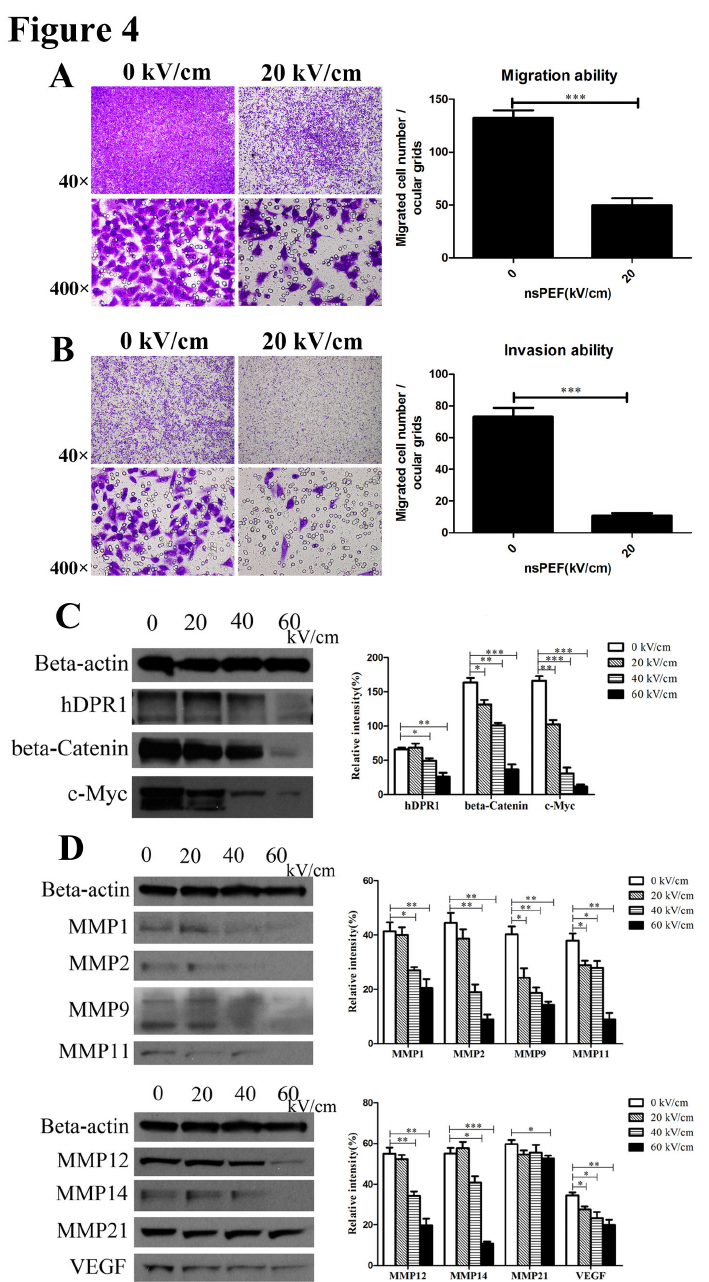
Figure 4. NsPEF inactivates cancer cells metastasis and invasion by inhibiting Wnt/β-Catenin signaling pathway to down- regulate expressions of VEGF and MMPs family proteins in vitro. (A) Migration ability of cancer cells exposed to nsPEF was tested by trans-well assay. The migrated cells exposed to nsPEF were stained purple by 0.1% crystal violet solution, observed under light microscope for 40 or 400 magnifications, and counted for statistical analysis. Original magnification, 40× & 400×. ***p<0.001. (B) Invasion ability of cancer cells exposed to nsPEF was detected using matrigel invasion assay. After nsPEF treatment, the cells that possessed invasion ability penetrated through the matrigel, were stained purple by 0.1% crystal violet solution, and were counted for statistical analysis. Original magnification, 40× & 400×. ***p<0.001. (C) Protein expressions of Wnt/β- Catenin signaling pathway including hDPR1, β-Catenin and c-Myc in cancer cells after exposure to nsPEF with different intensities were detected by Western-blot assay. (D) Protein expressions of MMPs family and VEGF in cancer cells after exposure to nsPEF with different intensities were detected by Western-blot assay. Relative intensity of each protein was analyzed by Photoshop CS4 software. *p<0.05, **p<0.01, ***p<0.001. doi: 10.1371/journal.pone.0074322.g004 PLOS ONE |